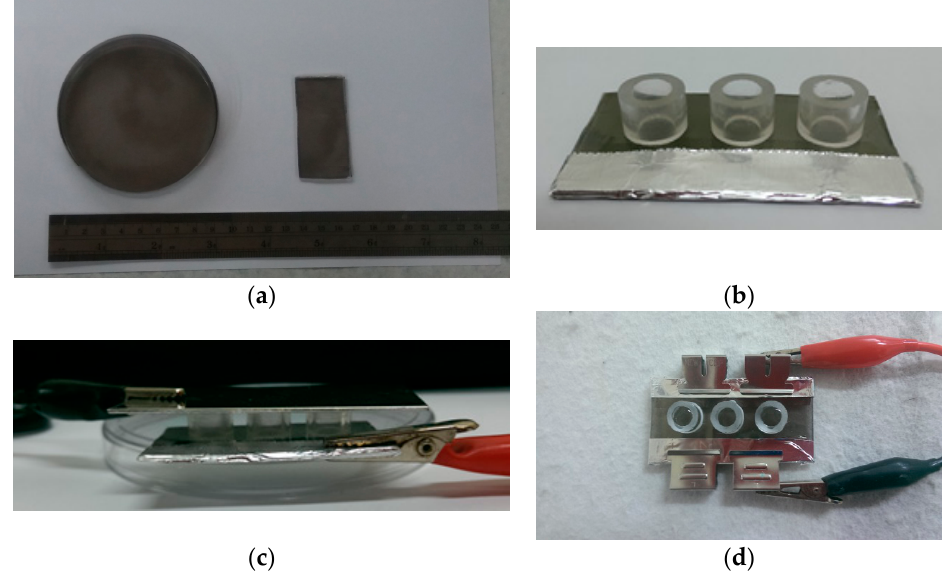
Figure 1. The electrical field administration to PEMs. ( a ) Polypyrrole (PPy) was deposited on polystyrene surfaces to form a conductive substrate, which was trimmed in the dimension of 6 by 3 cm. ( b ) Glass rings with an inner diameter of 6 mm and a height of 7 mm were glued on PPy films. ( c ) For the vertically electrical field, PBS was filled in the wells without bubbles, and the stainless steel counter electrodes were placed on the top of the wells. ( d ) For the horizontally electrical field, electrodes were placed at two opposing sides of the PPy films.